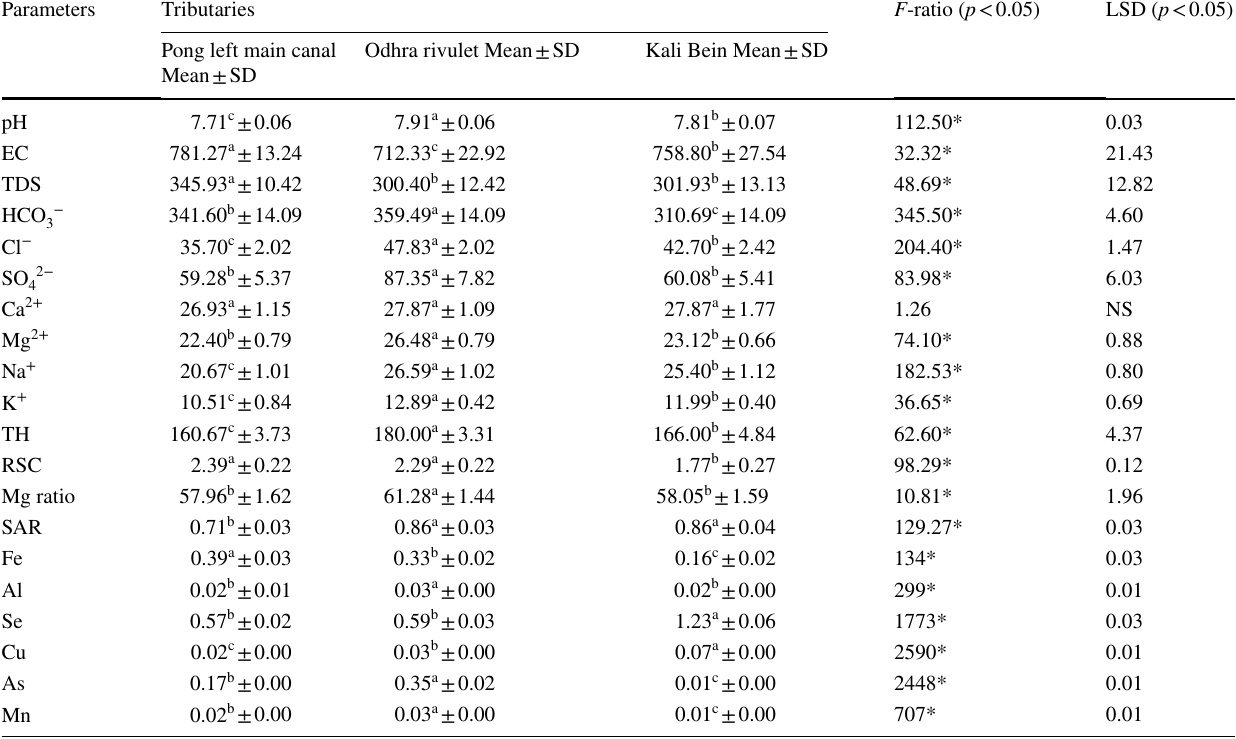
Table 2 One-way ANOVA and Tukey’s multiple comparison tests for water quality parameters of samples collected from the proximity of tribu- taries of Beas River, India for pre-monsoon period (June, 2019)